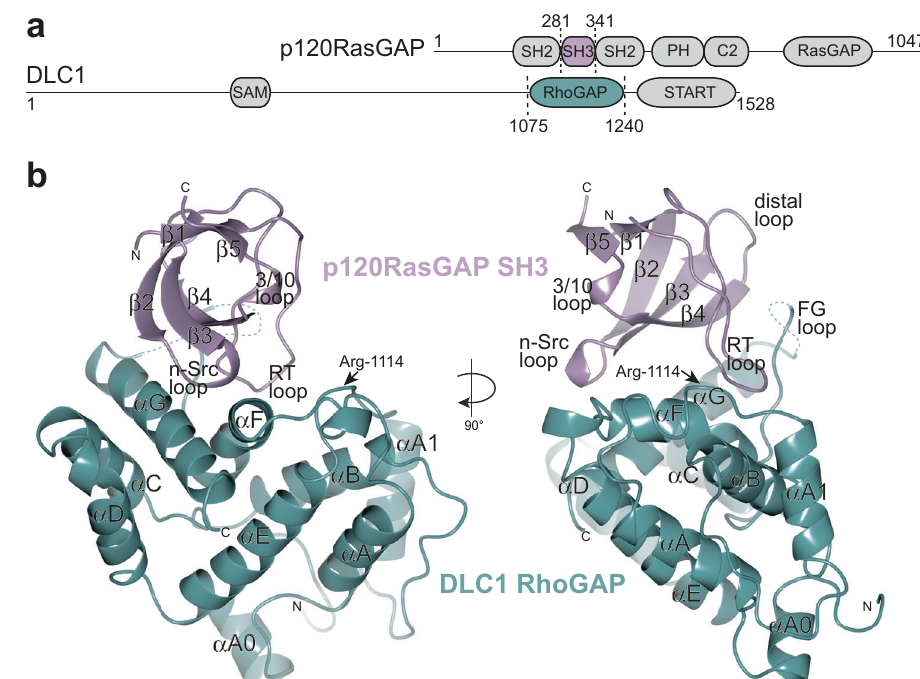
Fig. 1 | ComplexoftheSH3domain ofp120RasGAPand theRhoGAPdomain of DLC1. a Domain architecture of p120RasGAP (Uniprot ID: P20936. Domain IDs: SH2: Src Homology 2, SH3: Src Homology 3, PH: Pleckstrin Homology, C2: Protein Kinase C Conserved domain 2; RasGAP: Ras GTPase Activating Protein) and DLC1 (Uniprot ID: Q96QB1, SAM: Sterile Alpha Motif, RhoGAP: Rho GTPase Activating Domain, START: steroidogenic acute regulatory-related lipid transfer). Residue